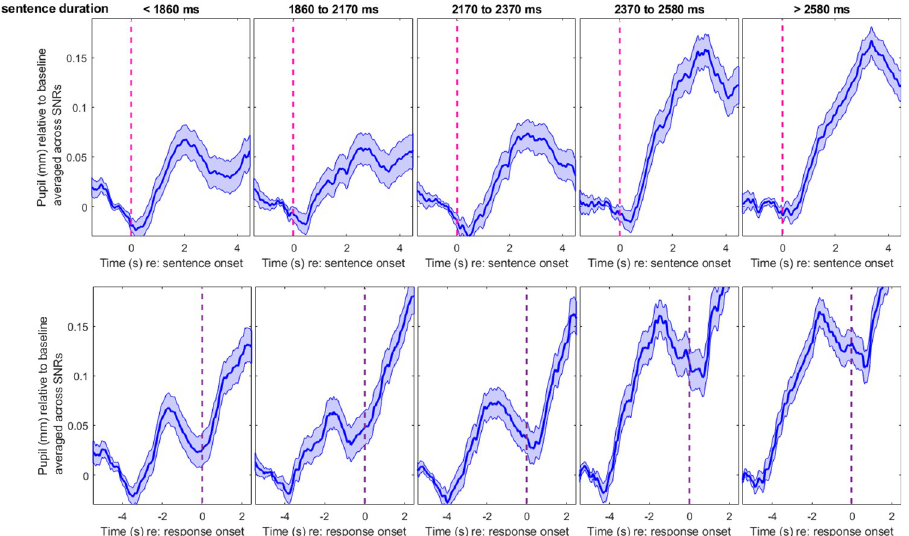
Fig 6. Pupil metrics across different sentence durations in Experiment 1. Baseline-corrected pupil traces measured in Exp.1 across different duration bins, aligned from the sentence onset (top) or from the response prompt (bottom). Longer sentences elicited larger PPDs, and whether this was accompanied by later PPDs depended on time alignment: The delayed PPD with longer stimuli is largely cancelled when sentences are aligned by their offset. Shaded area represented 1 standard error from the